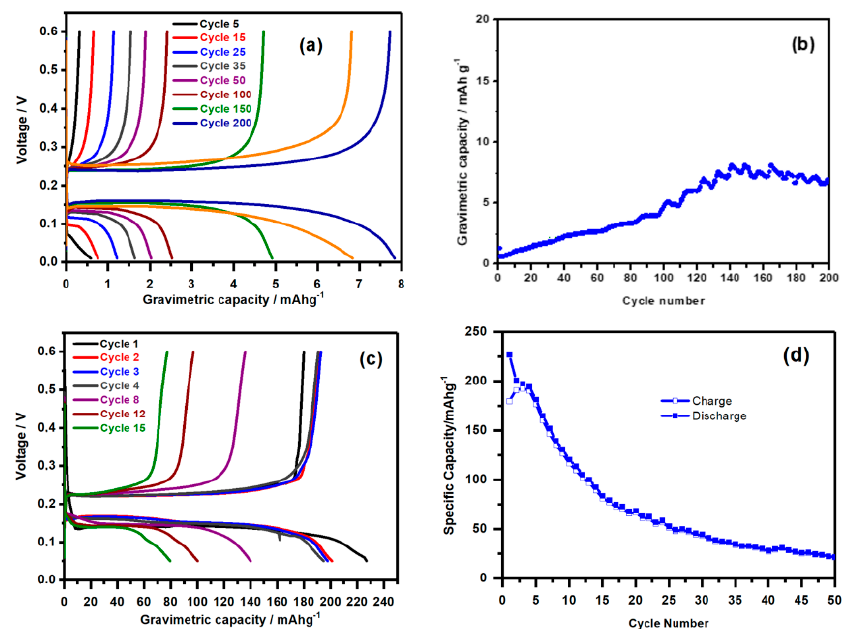
Figure 3. ( a ) Galvanostatic charge-discharge plots and ( b ) cycling performance at at 10 mA/g (C/20) current density of microparticulate β -Sn in Mg half-cell, using 0.5 M PhMgCl in THF as electrolyte. ( c ) Galvanostatic charge-discharge plots and ( d ) cycling performance at 10 mA/g (C/20) of nanoparticulate-Sn in in Mg half-cell using 0.5 M EtMgCl in THF as electrolyte. IS, QS, LW, % contribution and attribution of the signals appearing in the 119 Sn Mössbauer spectra of commercial micro- and nano-Sn, mechanochemically produced Mg 2 Sn and discharged/recharged electrodes. * Recoilless fractions, f = 0.05 (Sn and d-Mg δ Sn), 0.35 (SnO), 0.60 (SnO 2 ), and 0.3 (c-Mg 2 Sn) [28,29]. Copyright Elsevier, 2000, 1966. These values were